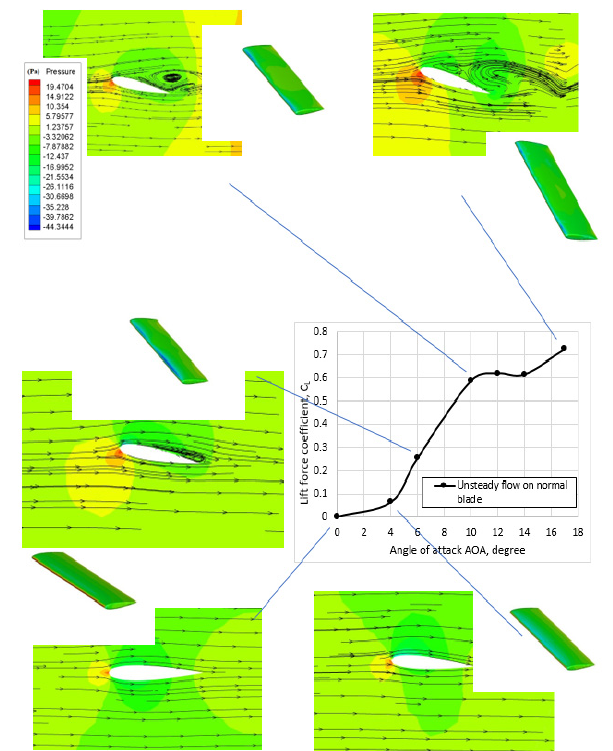
Figure 9. A contour plot showing the streamlines for different angles of attack at normal blade.